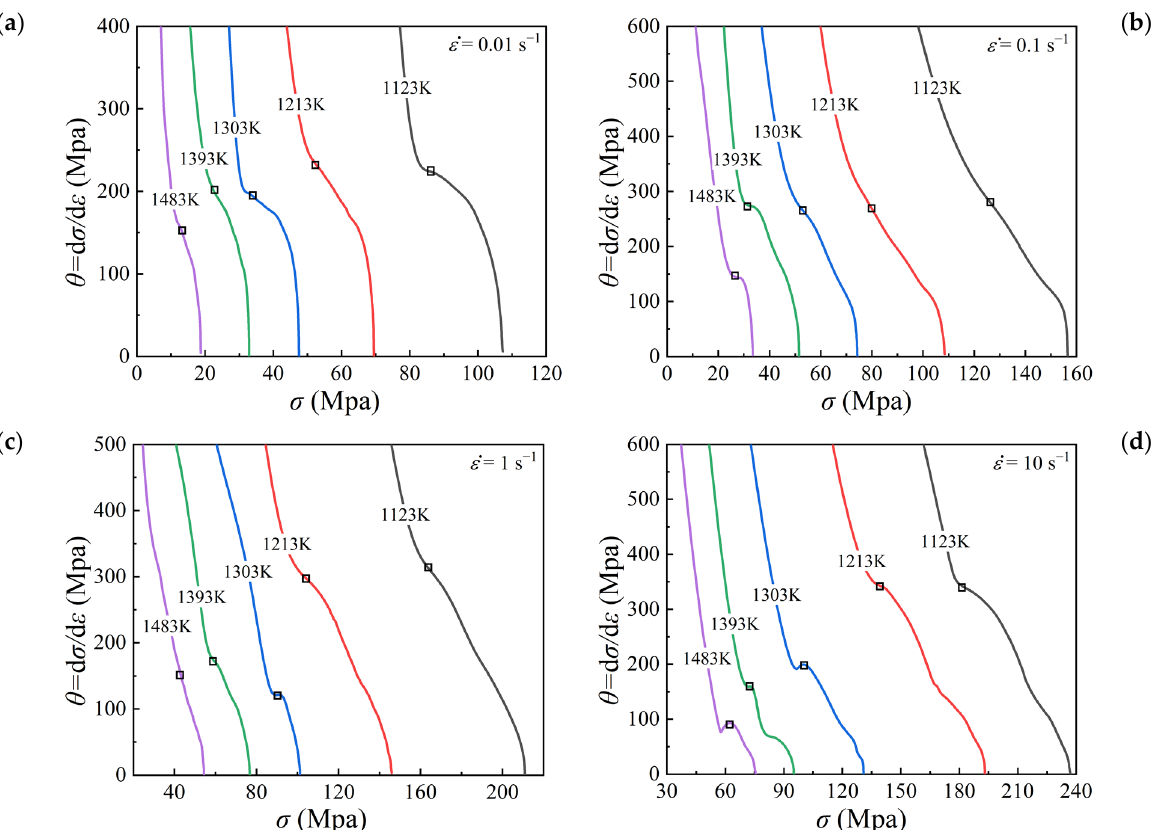
Figure 5. Curves of θ − σ under temperatures of 1123–1483 K and different strain rates: ( a ) 0.01 s − 1 , ( b ) 0.1 s − 1 , ( c ) 1 s − 1 , ( d ) 10 s − 1 . The marked squares represent the inflection points which correspond to the critical condition for the initiation of DRX.